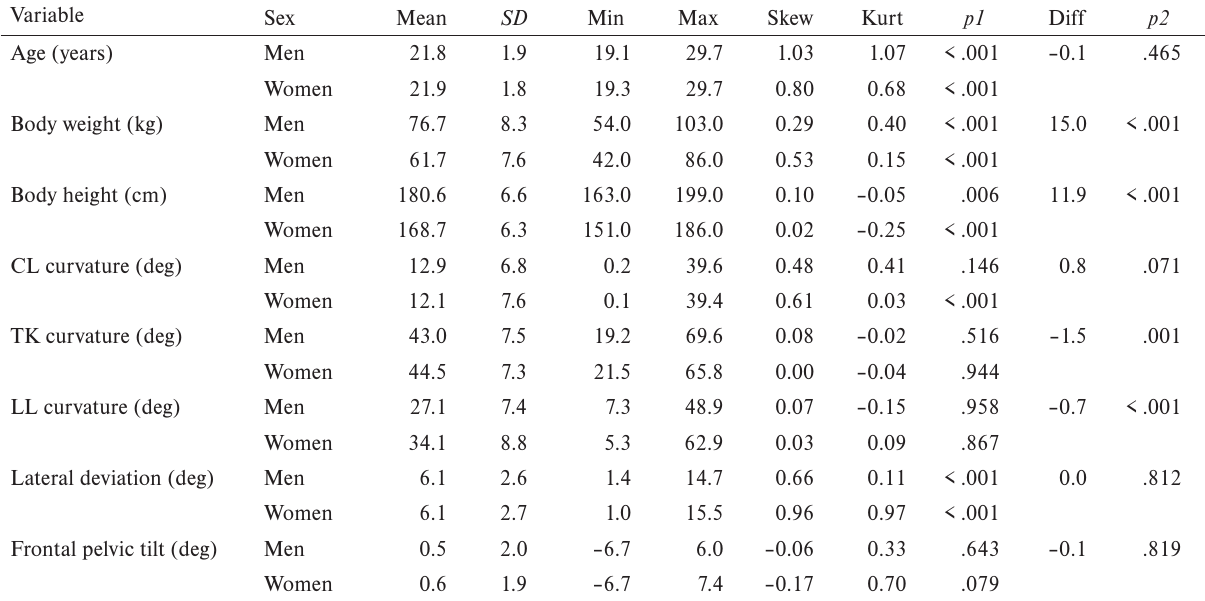
Statistics of age, anthropometric and spinal shape